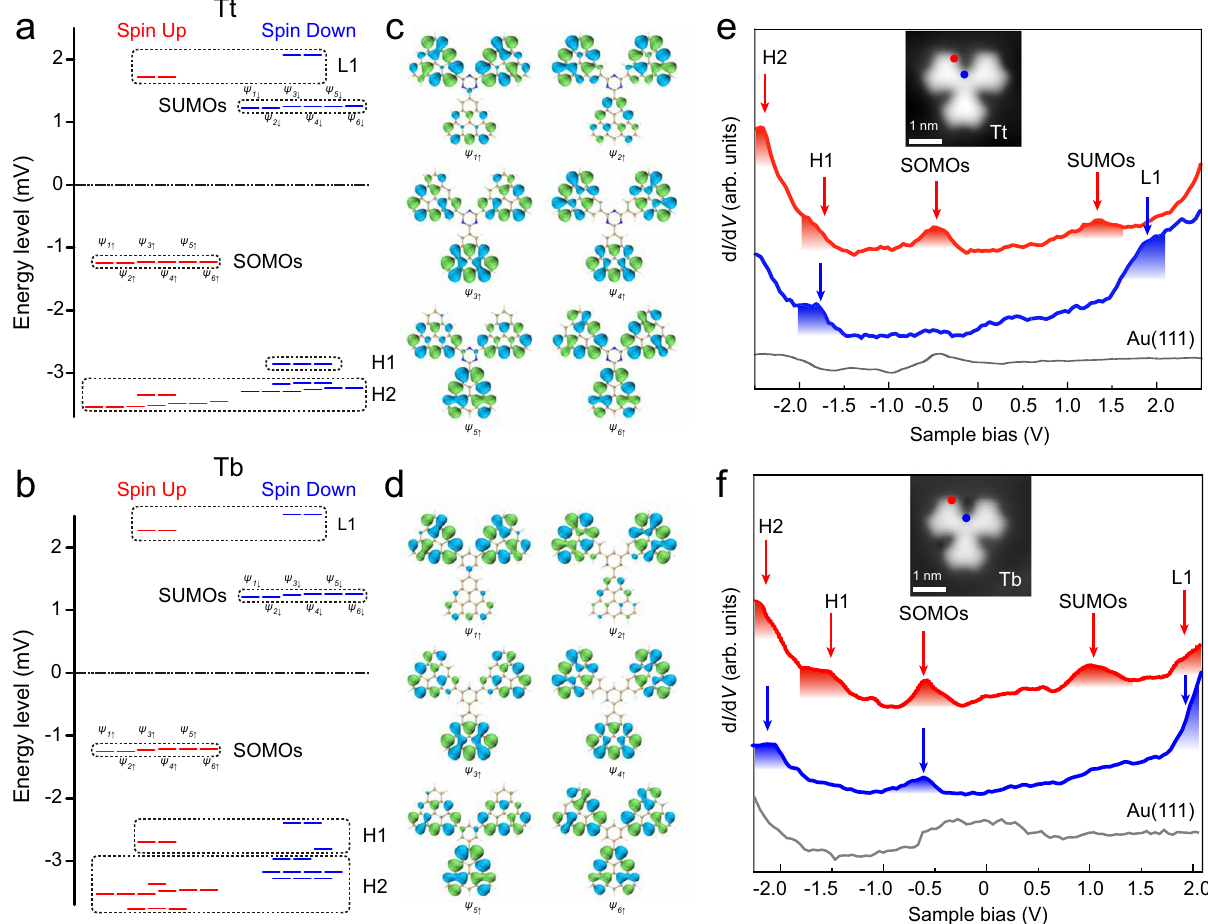
Fig. 4 Comparison of electronic structures between Tt and Tb. a , b DFT-calculated spin-polarized energy diagram of Tt and Tb. c , d DFT-calculated wave functions of six SOMOs. The blue and green isosurface colors indicate opposite phases of the wave function. e , f d I /d V spectra on Tt and Tb measured at the positions as marked with fi lled circles in the inset